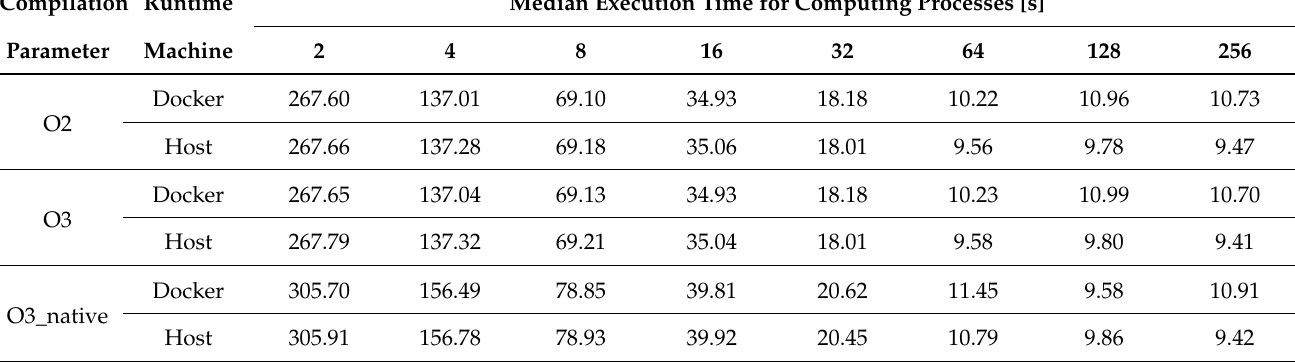
Table 1. Median execution times for